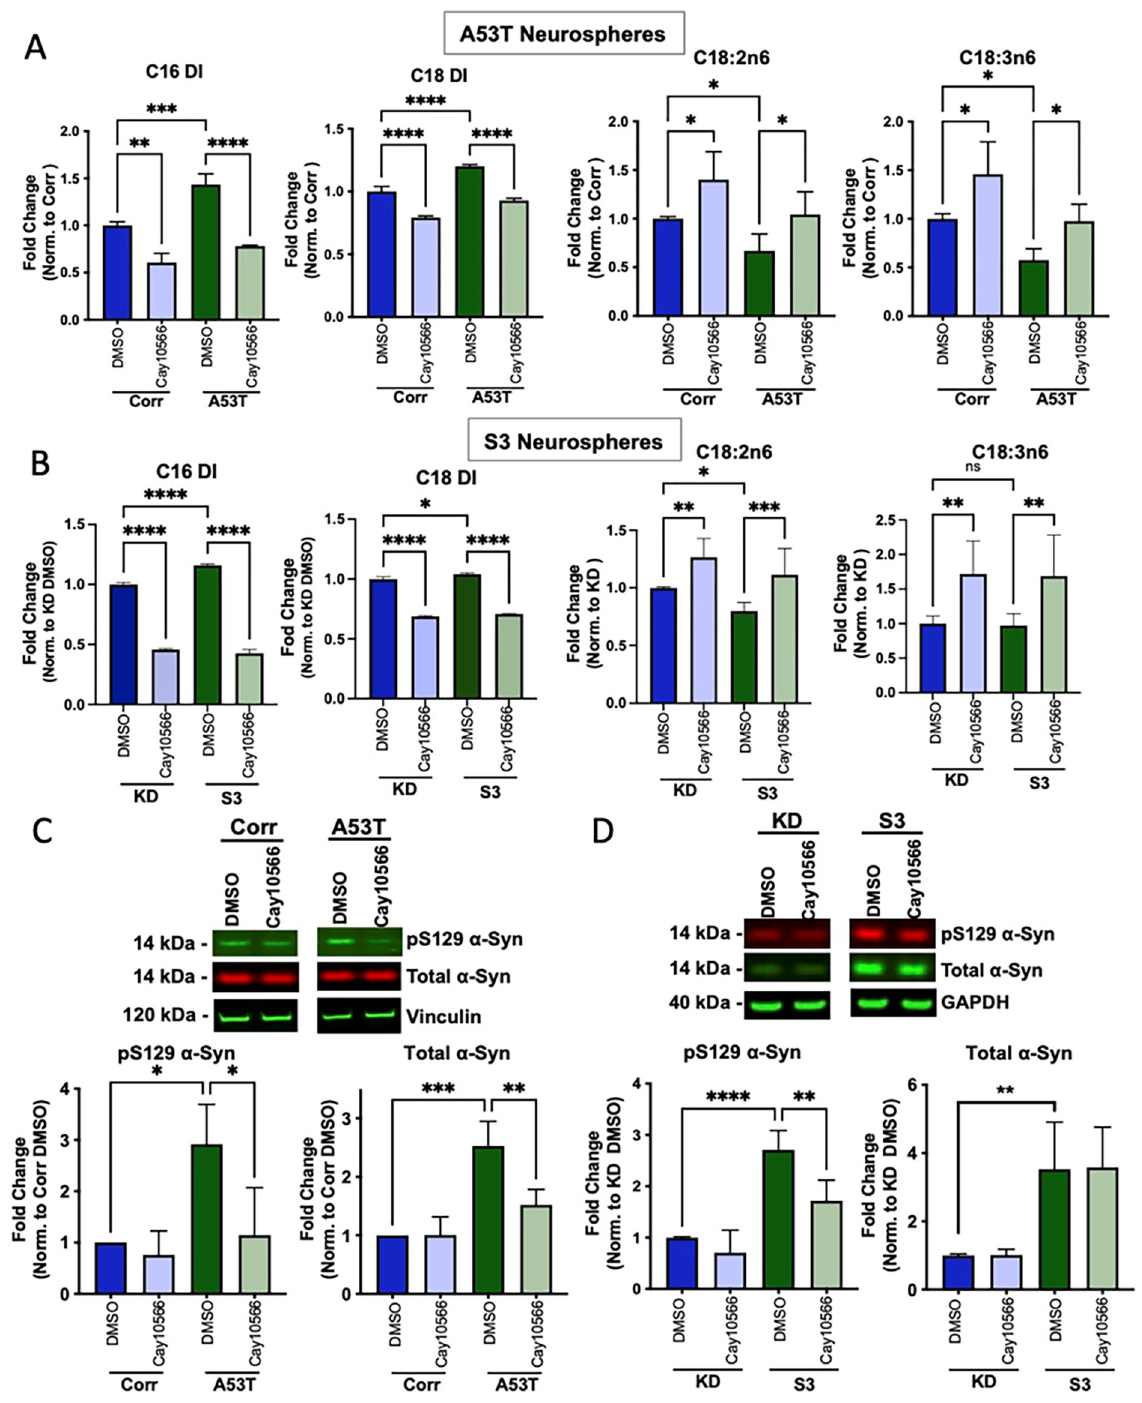
Fig 5. Treatment with the SCD inhibitor CAY10566 reversed the abnormal fatty acid profiles and pathogenic α -synuclein levels. A and B ) C16 and C18 desaturation index (DI) and essential fatty acids Linoleic (C18:2n6) and γ -Linolenic acid (C18:3n6) from A53T/Corr neurospheres ( A ) and S3/KD neurospheres ( B ) treated for 2 weeks with 0.03% DMSO and 0.3 μ M CAY10566. Data are from three independent neurosphere differentiations, with two biological replicates per differentiation, total 6 biological replicates. All values in each differentiation were normalized to the isogenic control groups treated with DMSO in each respective batch of differentiation. C and D) Representative Western blot (top panels) and quantification (bottom panels) for pS129 and total α -synuclein in 54-day-old cortical neurospheres from A53T/ Corr ( C ) and S3/KD ( D ) treated for 2 weeks with 0.03% DMSO and 0.3 μ M CAY10566. Quantification includes data from three (A53T/Corr)